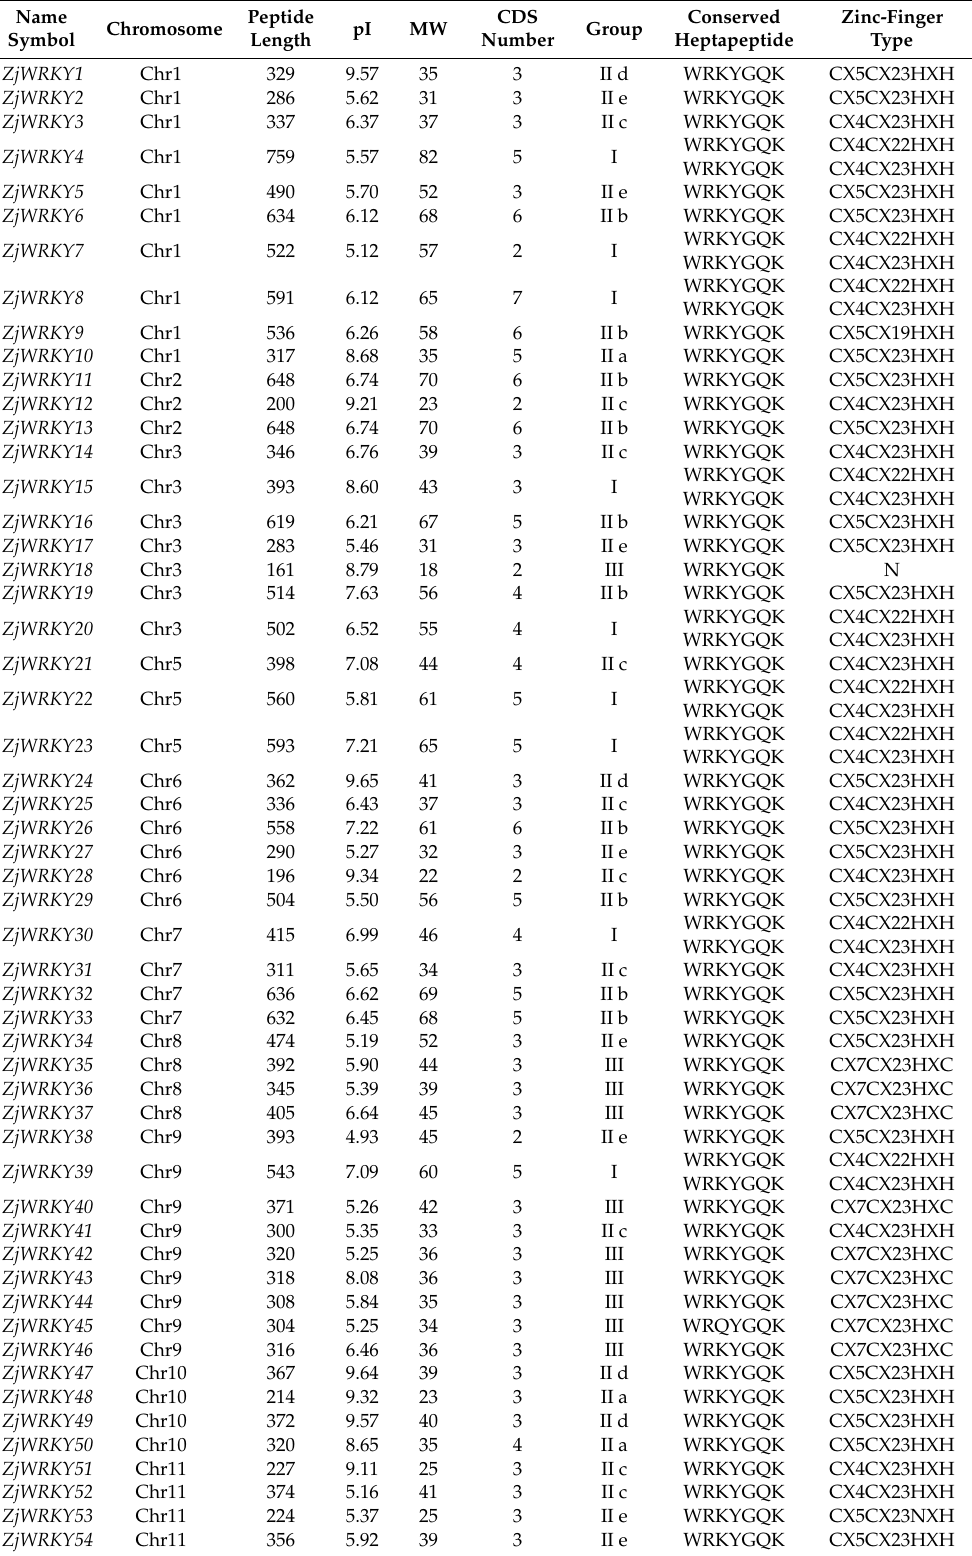
Table 1. Identified WRKY genes in the genome of Ziziphus jujuba